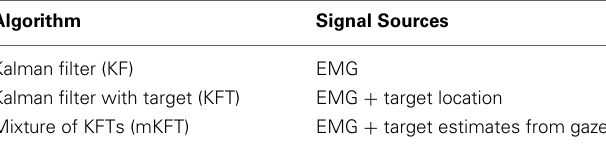
Table 1 | Decoders tested and the corresponding signal sources. Algorithm